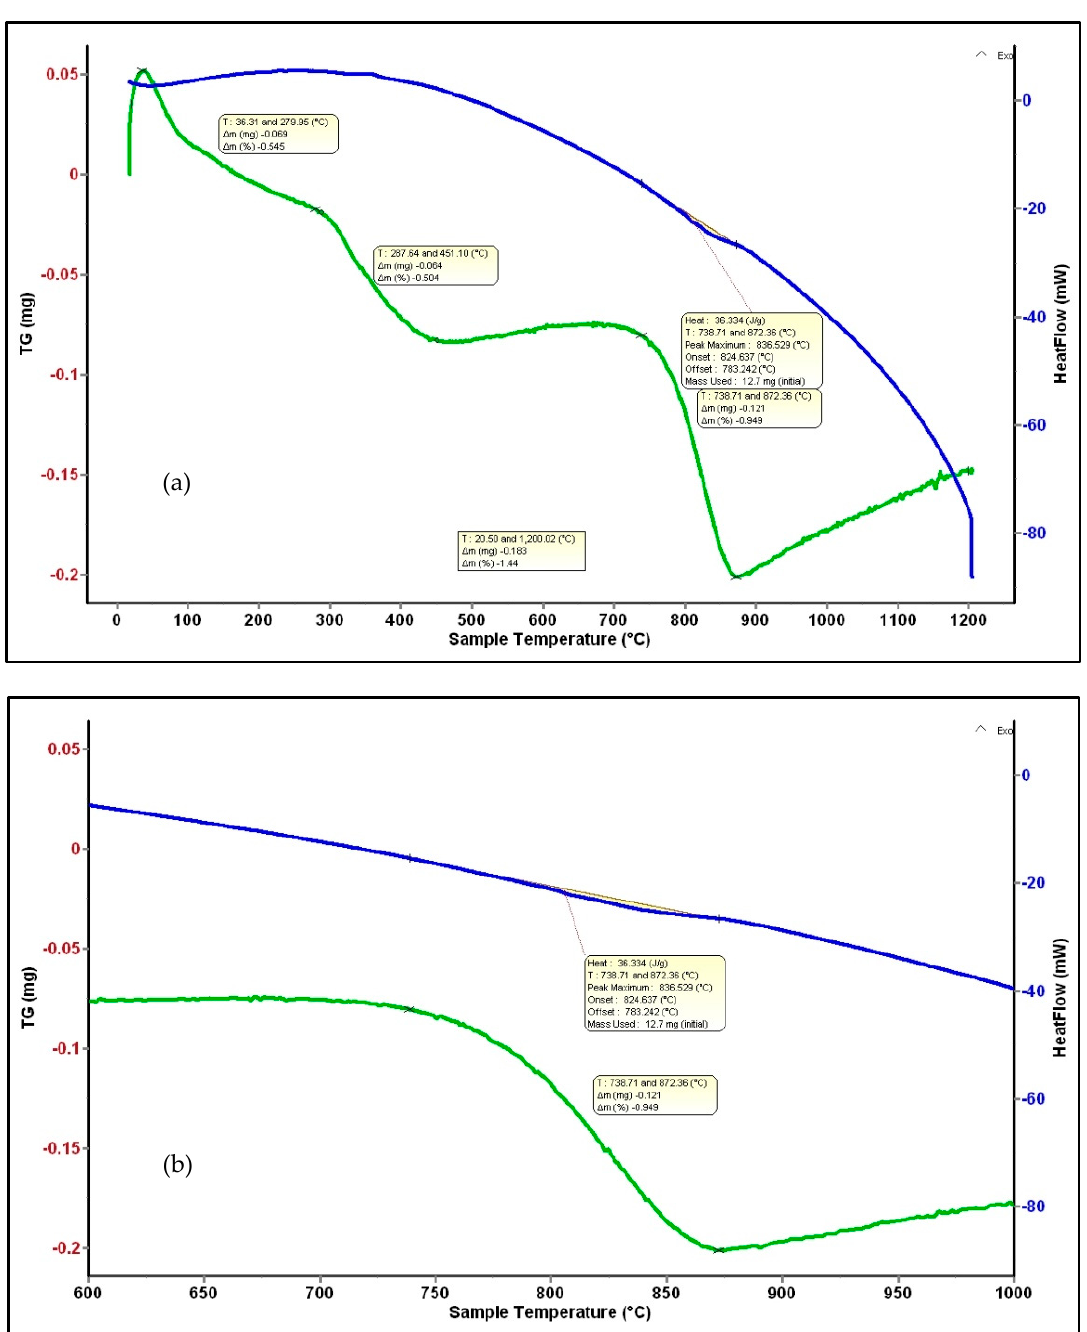
Figure 7. DSC-TG analysis of BSTCo5 powder ( a ) and a detail for the mass loss corresponding to the 836 °C peak ( b ).